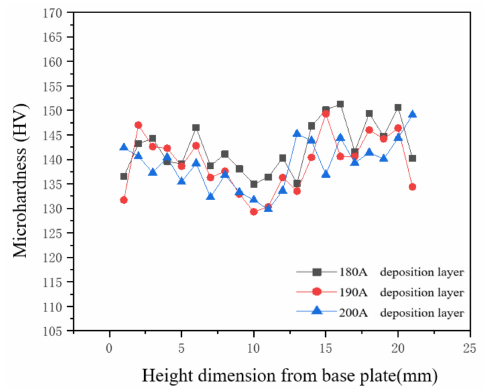
Figure 17. Microhardness curves of deposited samples fabricated using different